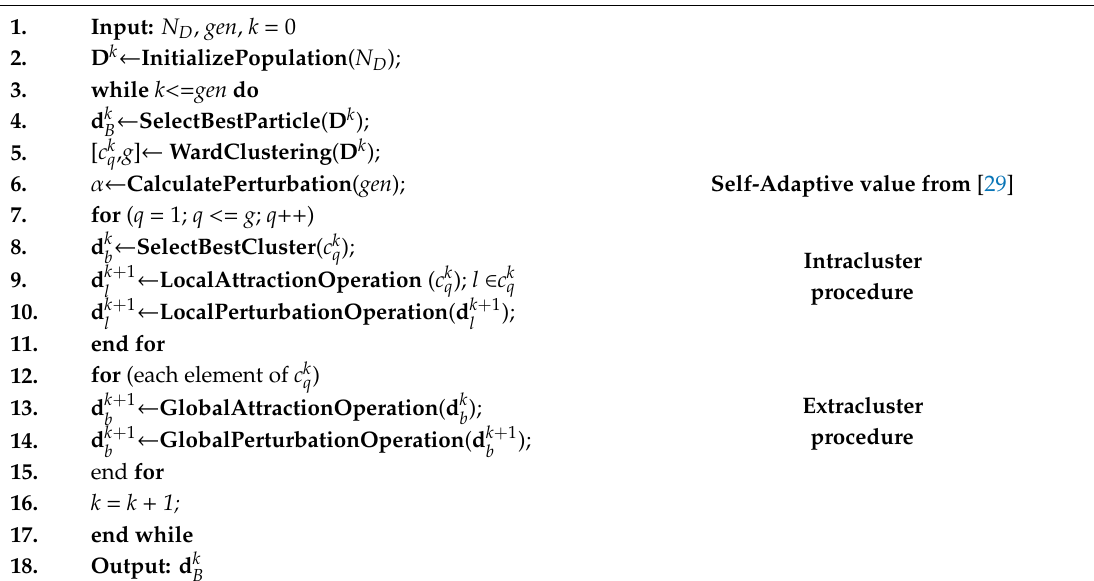
Algorithm 1. Pseudo-code for the Cluster-Chaotic-Optimization (CCO)